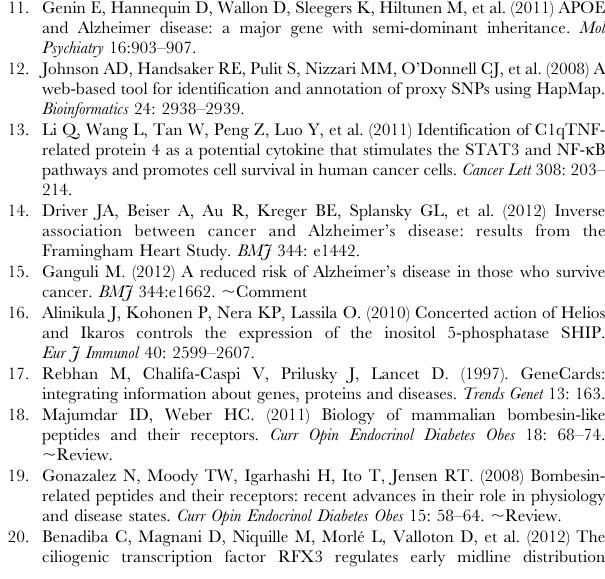
Table S1 Proxy SNPs from SNAP search (HapMap3 and 1000 Genomes combined) for published GWAS SNPs. Table S2 RegulomeDB Scores and Coordinates for